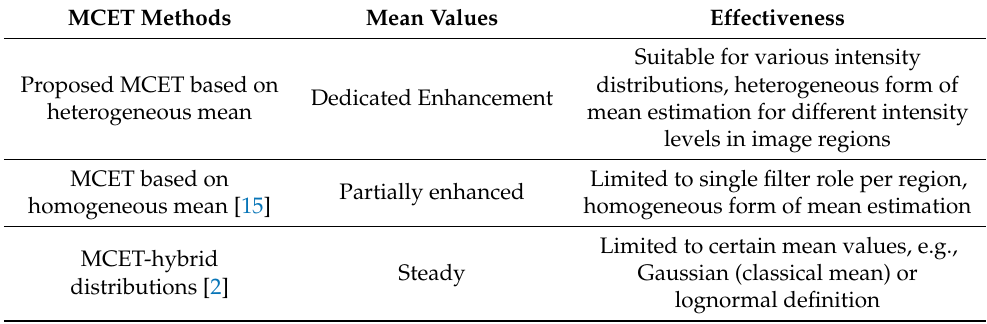
Table 1. Mean impact and effectiveness of the proposed method compared to the related